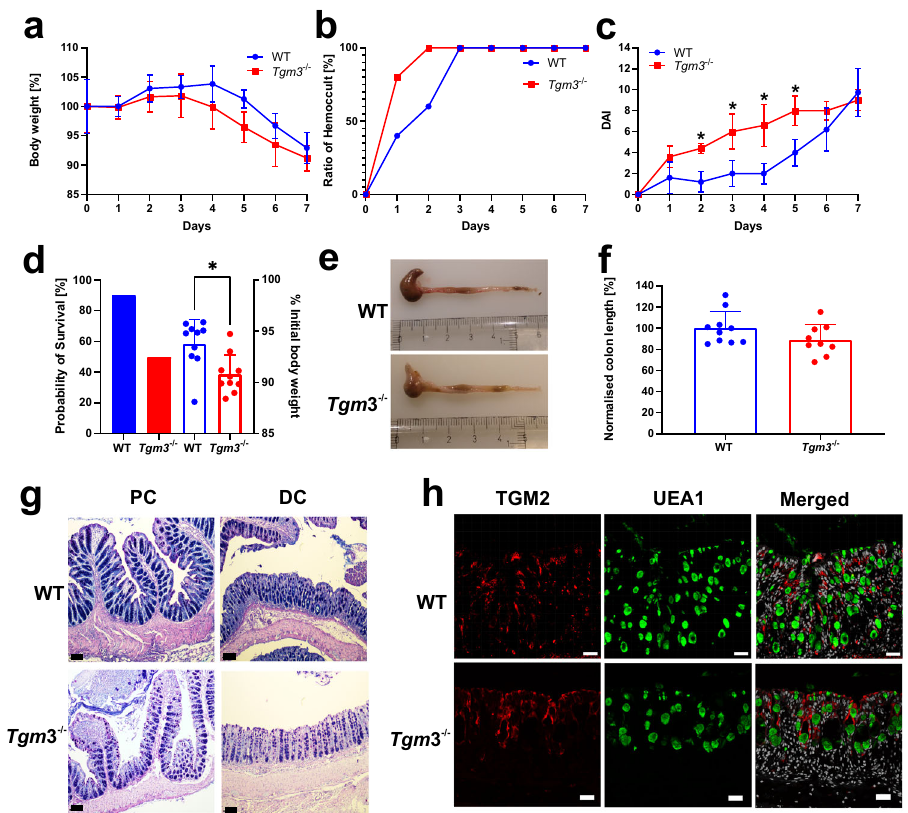
Fig. 4 Dextran sodium sulfate (DSS) treatment shows decreased mucus protection. WT and Tgm3 − / − mice were cohoused and supplied via drinking water with DSS. Data are presented as mean ± standard deviation. Source data are provided as a source data fi le. a Body weight change of DSS-treated mice over time ( n = 5). b Detection of occult blood. Fecal samples were analyzed for hidden blood using a hemoccult kit. The mean ratio of hemoccult- positive samples from each group was plotted against time ( n = 5). c The disease activity index (DAI) was determined as described in the methods section and the mean with standard deviation for both groups plotted against the time. (Multiple unpaired, two-tailed t-tests). Stars indicate an adjusted p value <0.05 for the respective data point ( n = 5). d Survival analysis of DSS-treated mice. Mice were sacri fi ced when the initial body weight loss exceeded 10%. The graph summarizes the probability of survival of the two mouse strains ( fi lled bars) and the percentage of the initial body weight at the ethical endpoint (scatter plot; two-tailed Wilcoxon test, * p = 0.0137). Two litters per strain were analyzed independently representing ten animals in each group. e – f Colon length changes of DSS-treated WT and Tgm3 − / − mice. At the ethical endpoint, animals were sacri fi ced and the colon length of each animal measured. A representative colon of WT and Tgm3 − / − animals is shown in ( e ). f Normalized colon length of DSS-treated WT and Tgm3 − / − mice. The graph shows the summary of two litters per strain analyzed independently representing ten animals in the WT and nine animals in the Tgm 3 − / − group ( p = 0.1214). g Histological analysis of DSS-treated WT and Tgm3 − / − mice. Representative Alcian Blue-Periodic Acid Schiff-stained sections from proximal (PC) and distal colon (DC) of WT and TGM3-de fi cient animals are shown ( n = 5). The black scale bar corresponds to 100 μ m. h Immunohistochemical analysis of WT and Tgm3 − / − mice for the presence of TGM2 after DSS treatment. Tissue specimen from WT and Tgm 3 − / − animals were probed with an anti-TGM2 antibody (red) and the UEA1 lectin (green). Nuclei were stained using the Hoechst stain (gray). n = 5. The white scale bar corresponds to 30 μ the label-free mass spectrometric quanti fi cation TGM2 was <1%